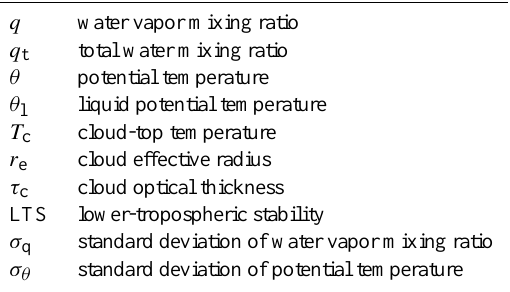
Table 3. Acronyms and symbols used in